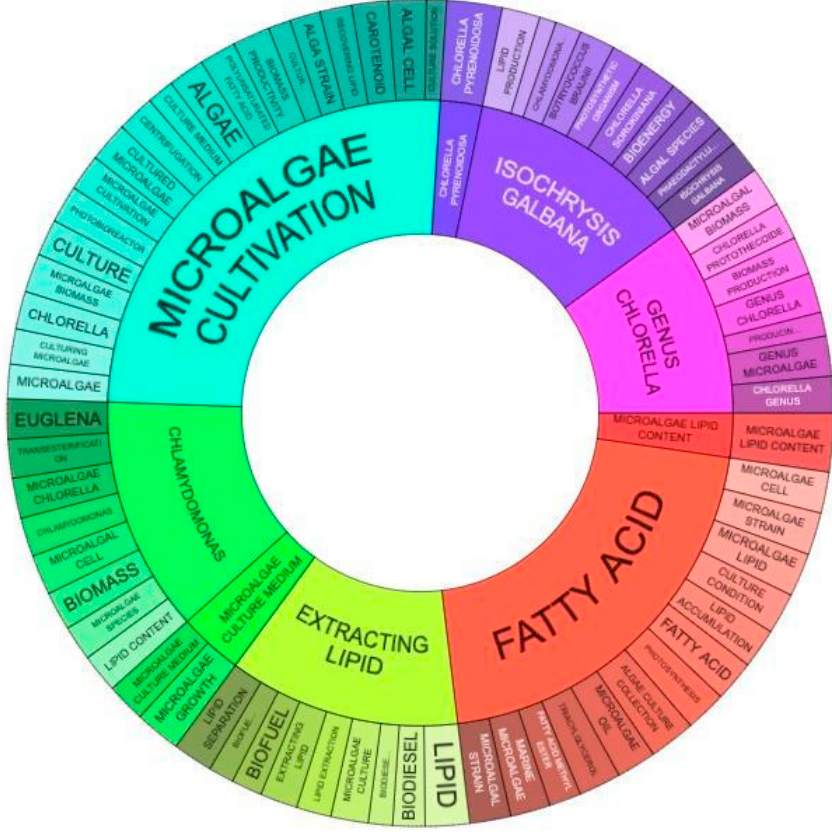
Figure 12. Clusters of the most repeated keywords in the document portfolio.